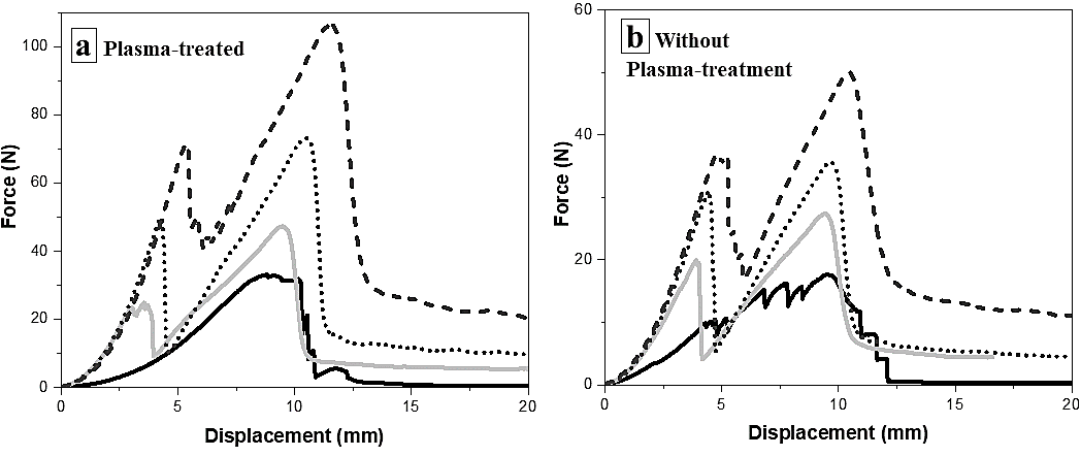
Figure 4. Force-versus-displacement curves from the spike penetration test on single-layer UHMWPE fabric samples: —, neat; — (gray color), coated with PU; ••• , coated with 30 wt.% SiC in PU; —, coated with 50 wt.% SiC in PU; ---, coated with 50 wt.% SiC in PU.